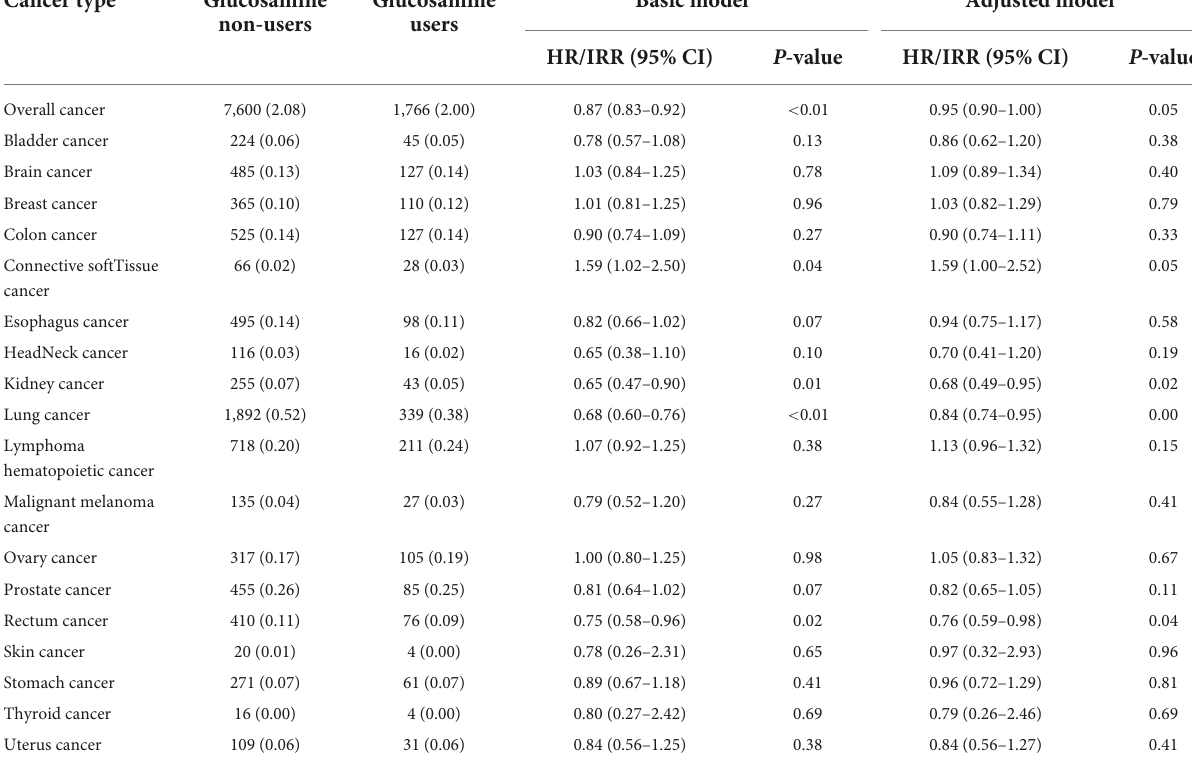
TABLE 2 Associations of glucosamine supplement use with cancer